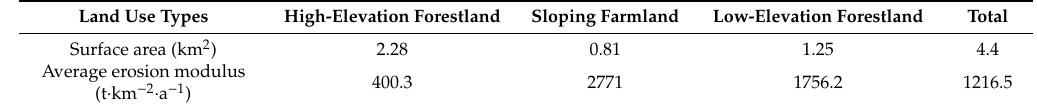
Table 2. The soil erosion modulus of the Liangshan Town